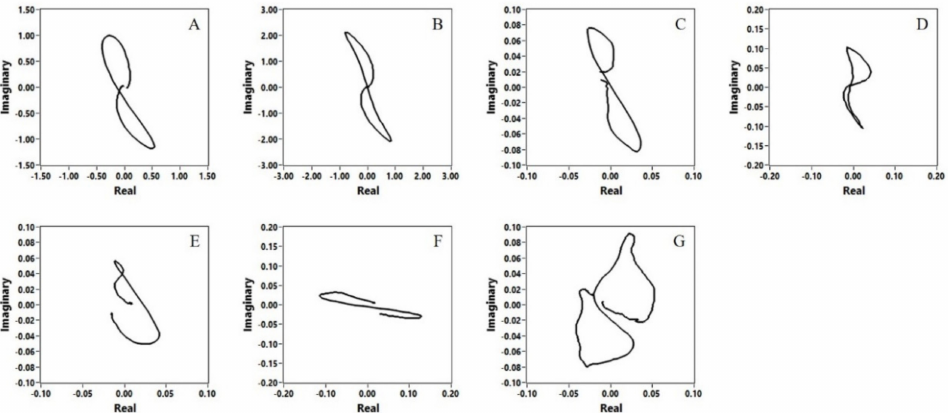
Figure 6. Lissajous curves from the front bobbin coils for the specimen with di ff erent type flaws (100 kHz